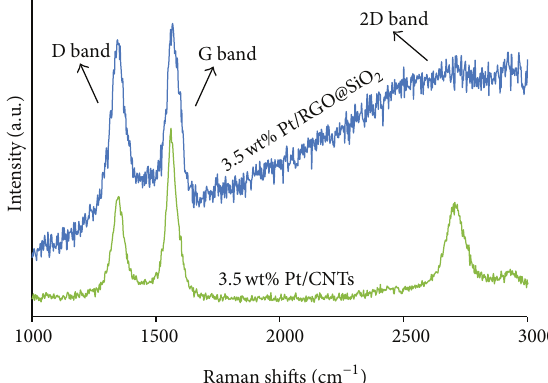
Figure 2: Raman spectra of 3.5 wt% Pt/RGO@SiO 2 and 3.5 wt%